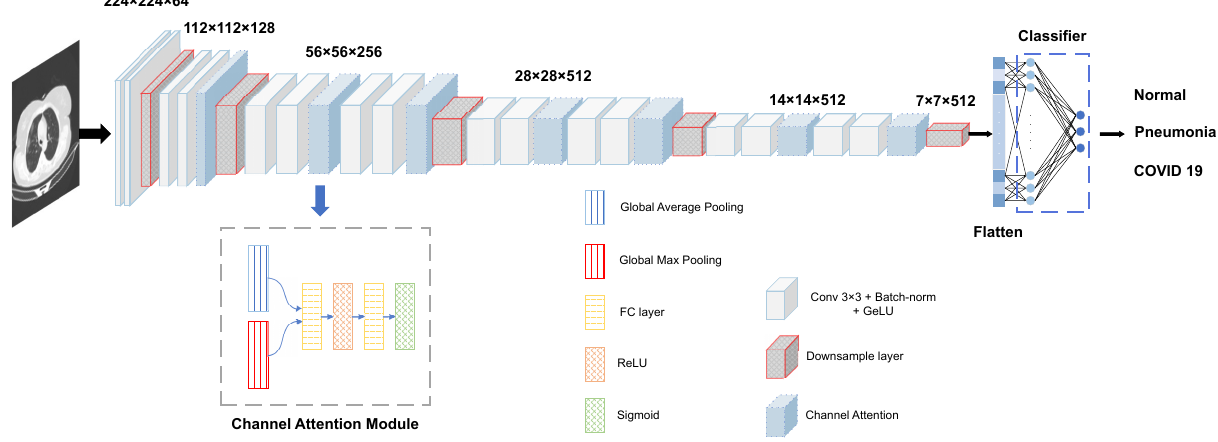
Figure 4. Architecture of the improved